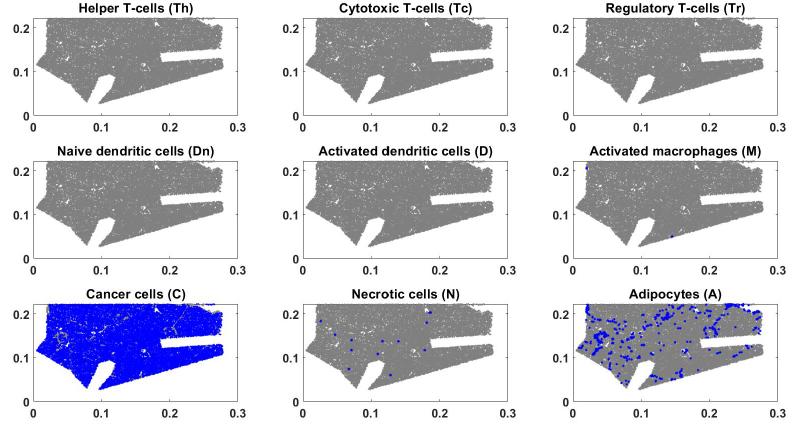
Figure 7. Nine figures showing each cell type in the mouse model. Blue dots represent a single cell of the corresponding cell type, and gray dots represent the rest.